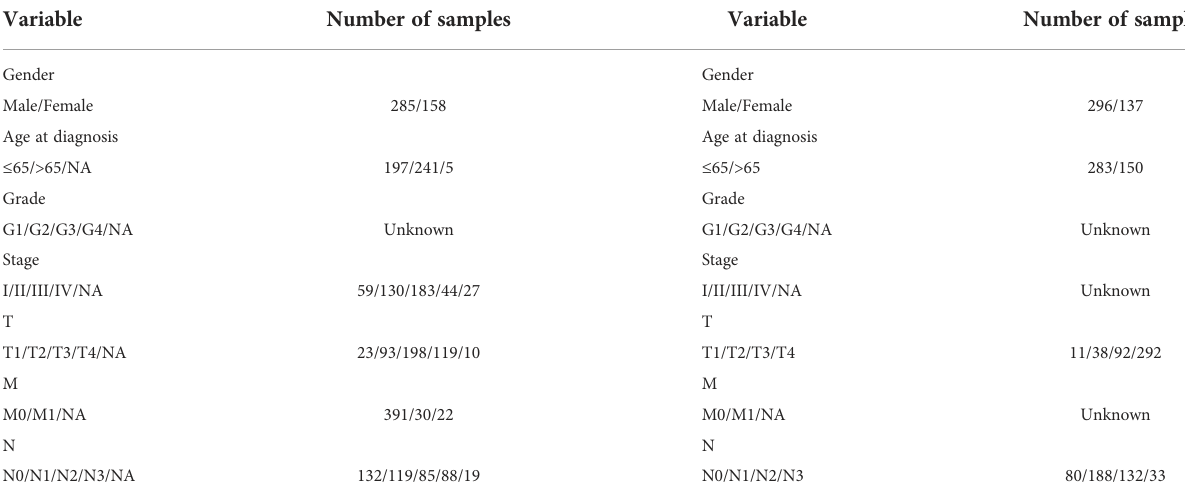
TABLE 1 Patient clinical